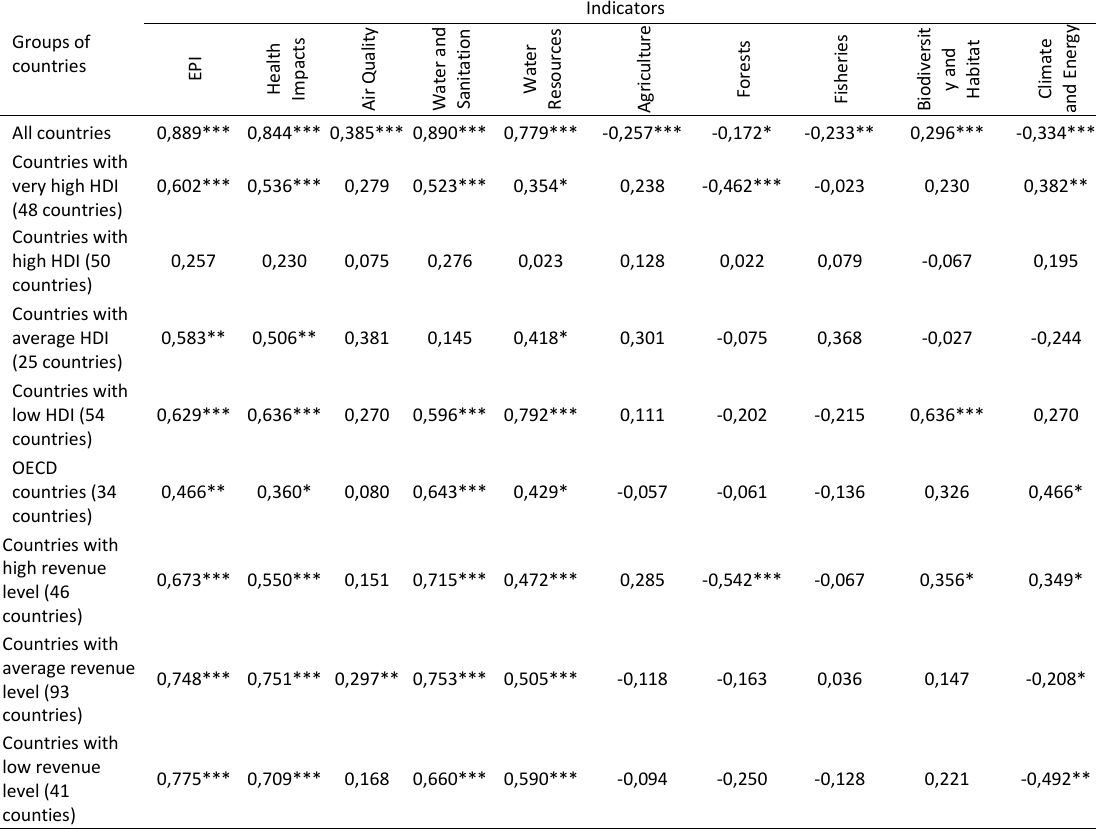
Table 2: Correlation coefficients between the EI and EPI, as well as its individual components